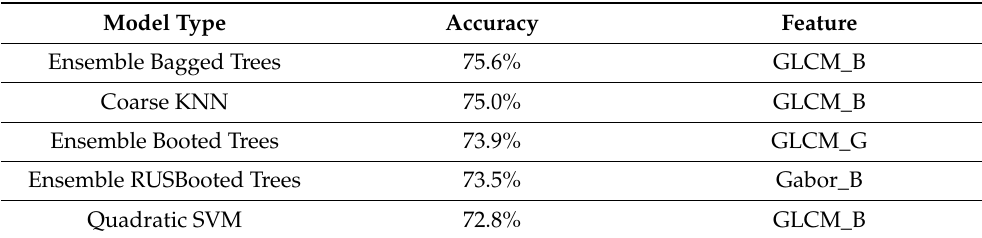
Table 1. The top five accuracies using the texture features and different classifiers.